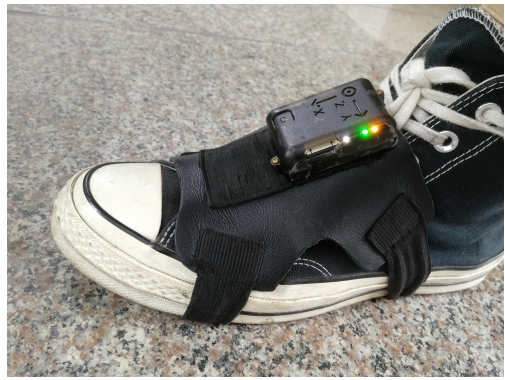
Figure 2. NGIMU attached on the left foot. Table 2. Performance of sensors on the